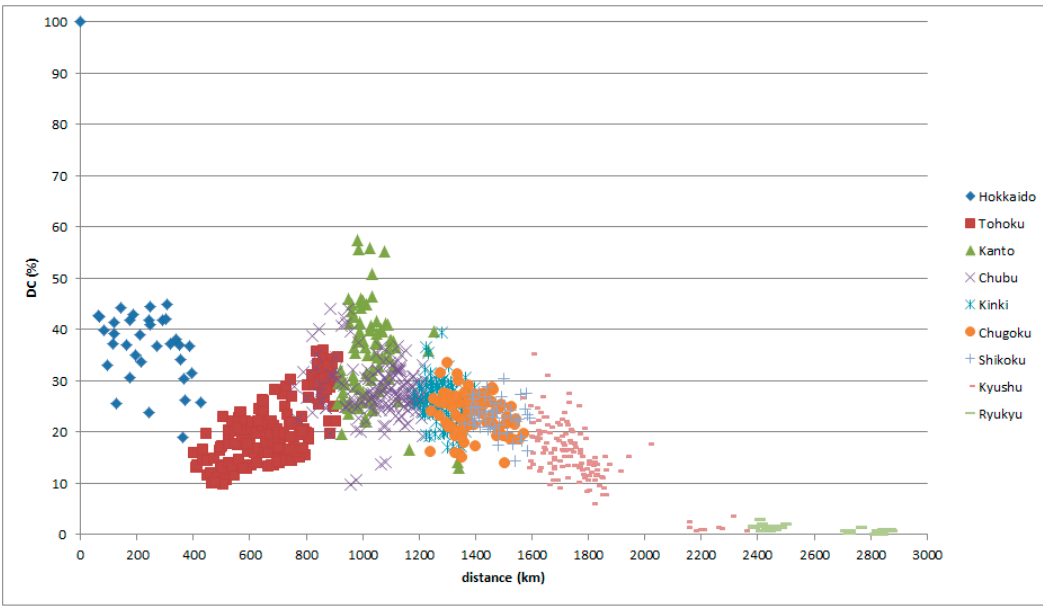
Figure 16. LAJ data with reference place in Hokkaido, classified by comparison place.